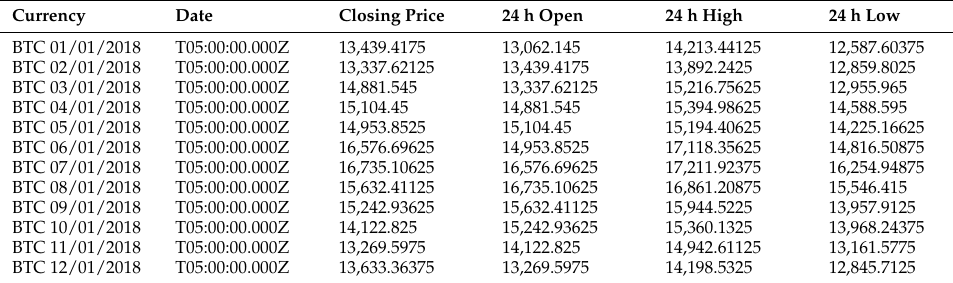
Table 3. Extraction model of Bitcoin statistics in